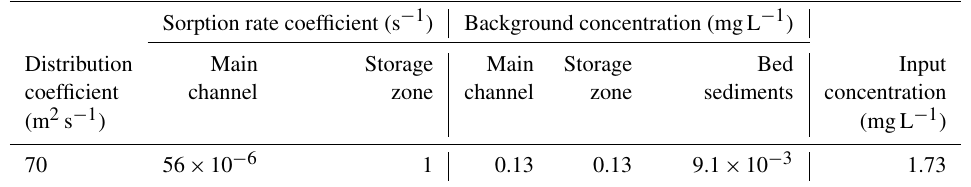
Figure 13. Observed and simulated chloride concentrations in the main channel (test case 3). Table 12. Simulation parameters related to test case